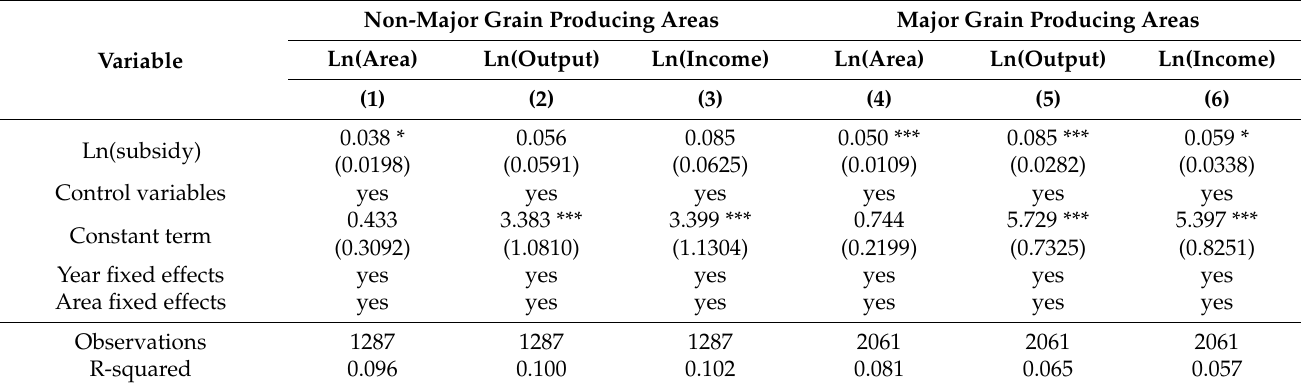
Table 7. Regression results of distinguishing major and non-major grain producing